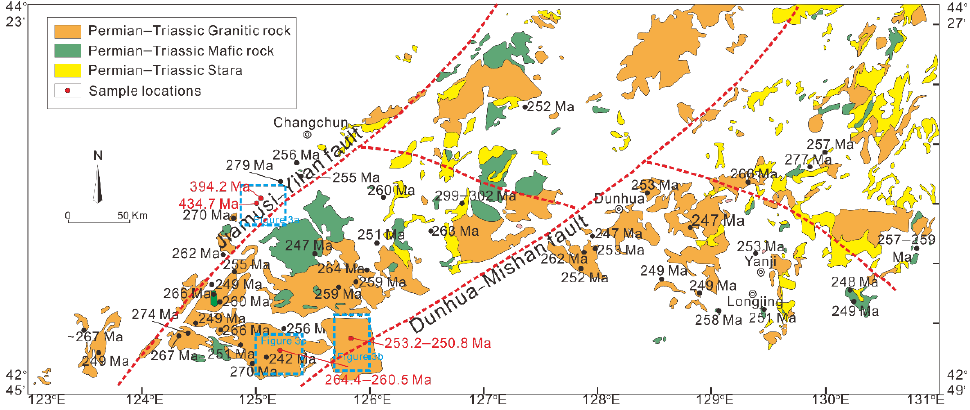
Figure 2. Distribution of the Permian to Triassic magmatic rocks in the central Jilin Province, southeastern CAOB. Figure 3a – c marked in the figure is the location of the study area in this paper. Age data and references presented in Supplementary Material Table S1.